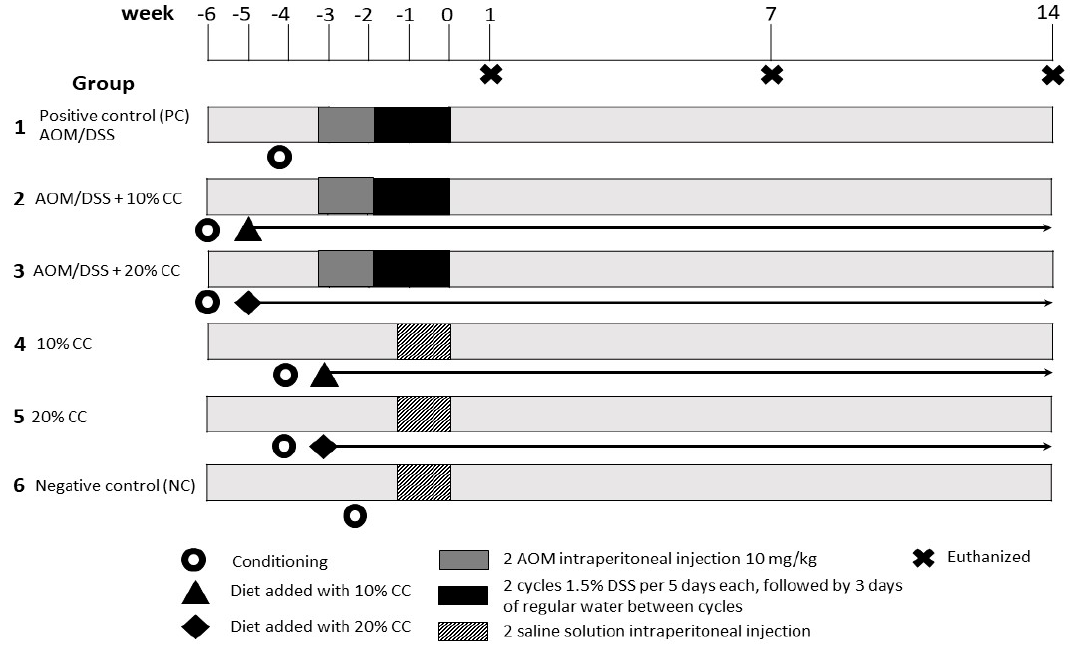
Figure 1. Experimental design of AOM/DSS colon carcinogenesis model to evaluate cooked chickpea (CC) antioxidant activity. NC: negative control; PC: positive control; AOM: azoxymethane; DSS: dextran sulfate sodium; CC: cooked chickpea.